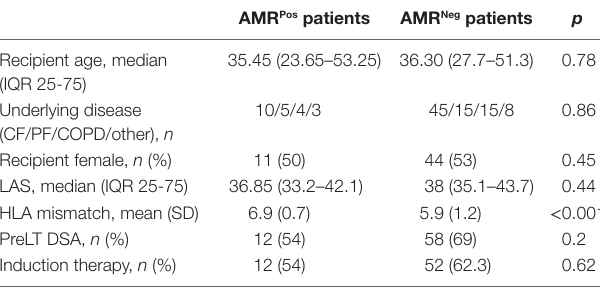
Table 2 | Baseline clinical